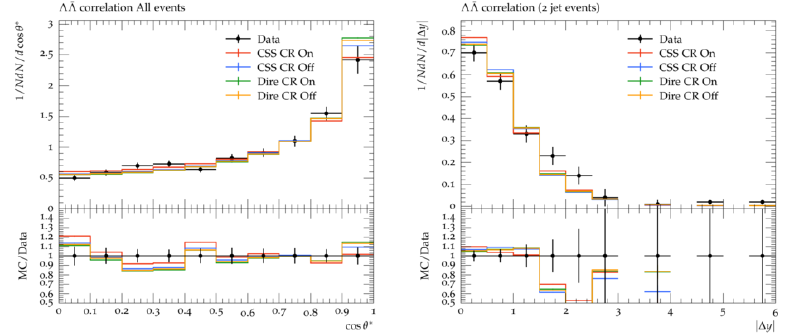
Figure 11: Correlation of Λ ¯ Λ pairs in e − e + → hadrons at 91.2 GeV. We contrast S HERPA results with data from O PAL [ 48 ]